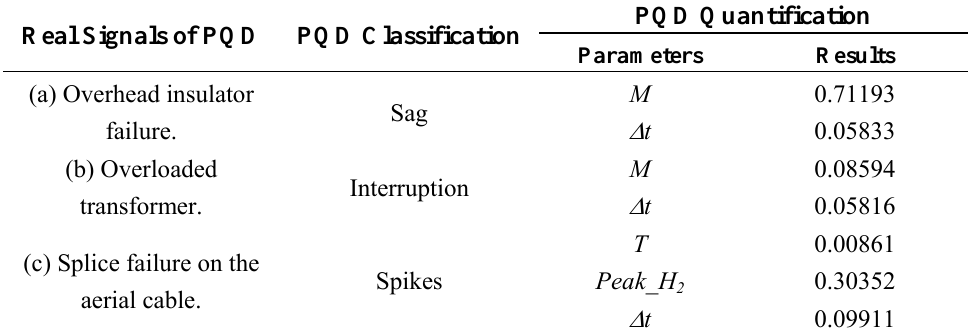
Table 8. Classification and quantification results of the proposed approach under real